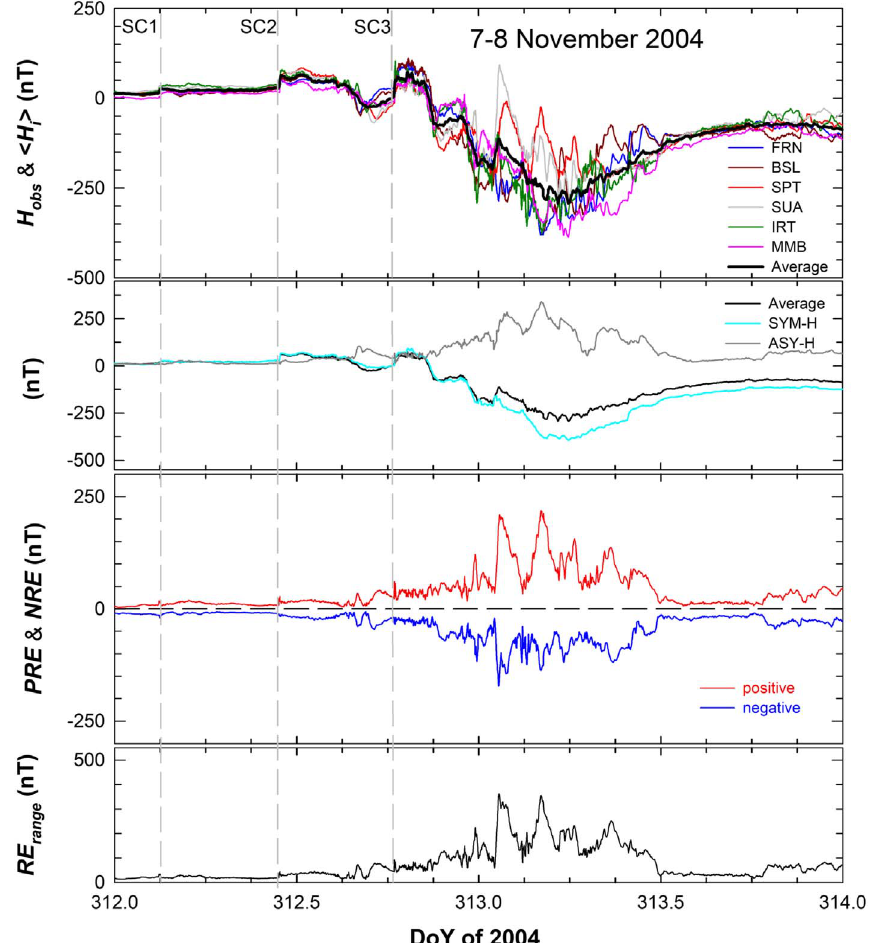
Fig. C.7. The event on 7 – 8 November 2004 (event